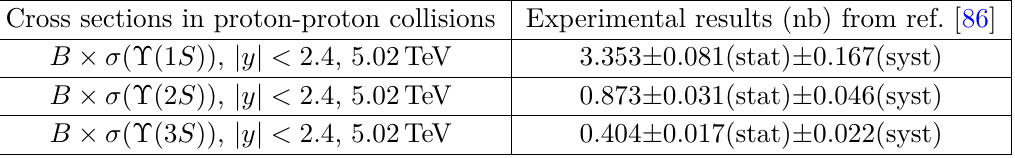
Table 2. Experimental inputs of cross sections in proton-proton collisions, where B indicates the branching ratio of the relevant state to µ + µ − .